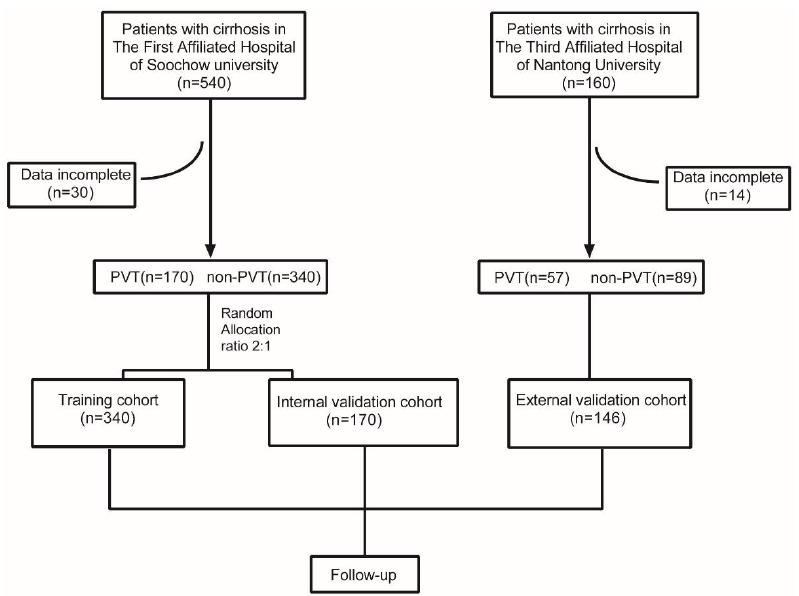
Figure 1. Flow diagram of the present study, PVT—portal vein thrombosis. Randomization was performed with R software.